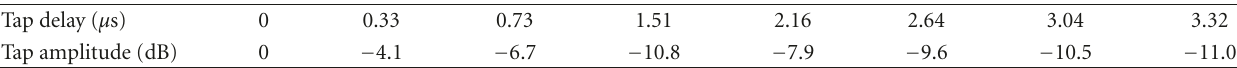
Table 1: Bug UN2 channel characteristics.